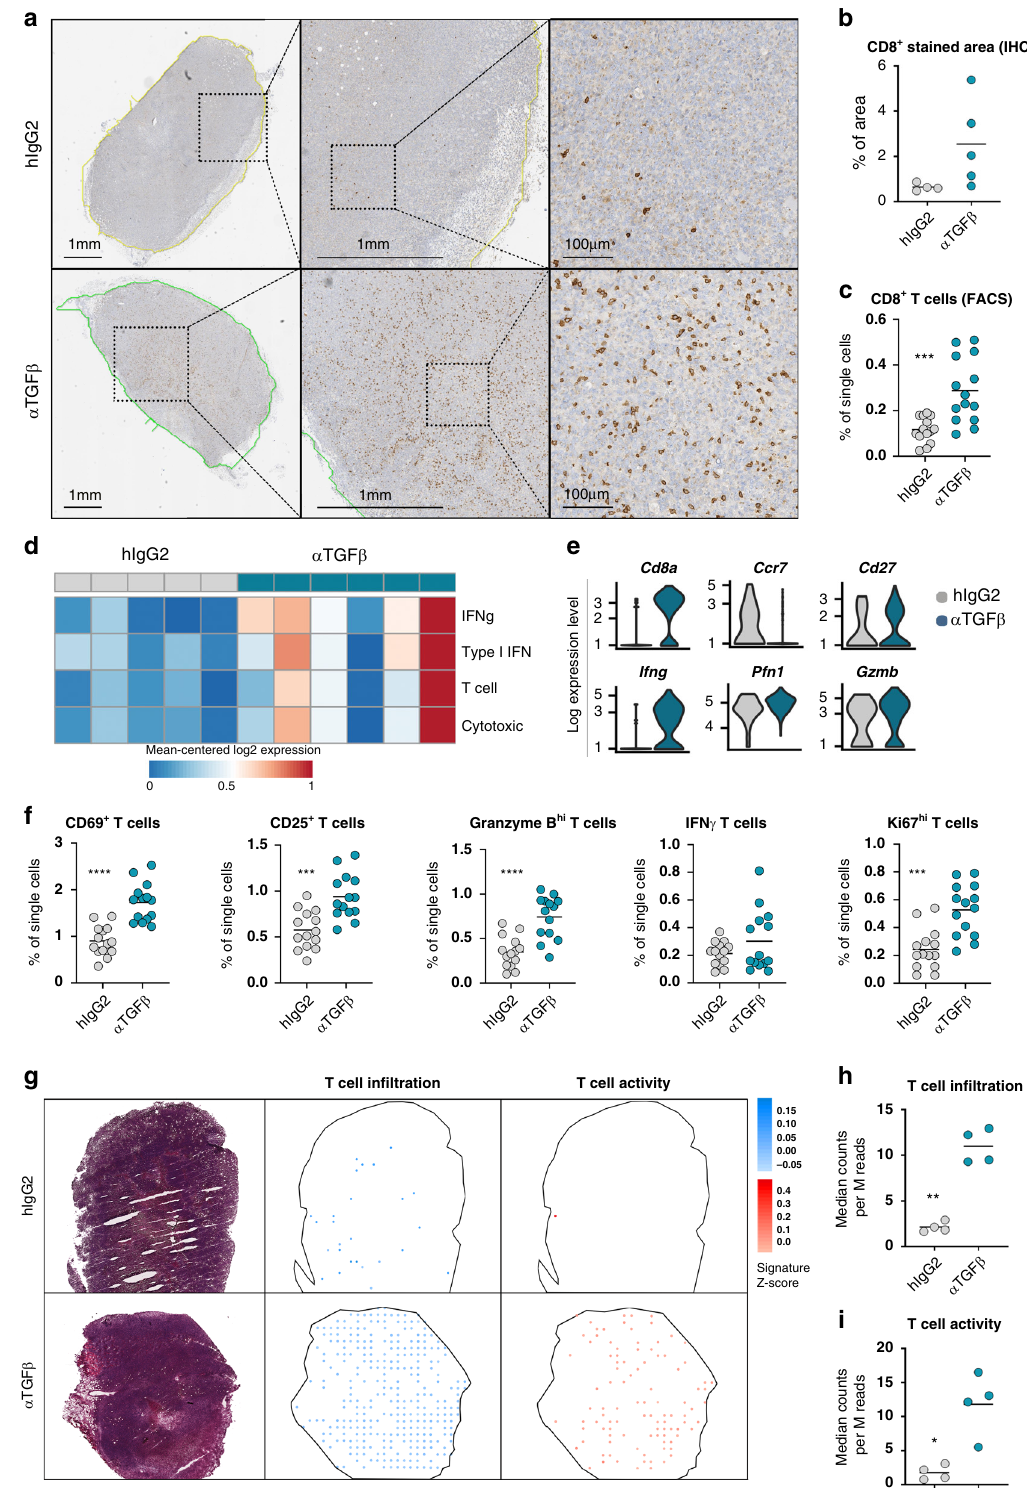
analysis of gene signatures associated with T cell effector func- tions also depicted an augmentation of T cell functional activity in tumor samples from anti-TGF β -treated mice (Fig. 6d), sup- porting the idea that TGF β -blockade may result in overall awa- kening of immune cell responses. These fi ndings were